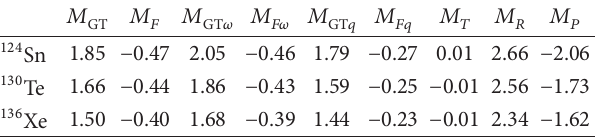
Table 1: The nine NME of 124 Sn, 130 Te, and 136